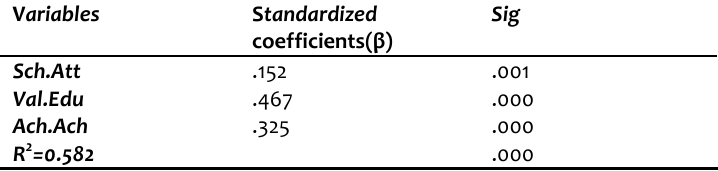
Table ‐ 5: Results of multiple ‐ regression